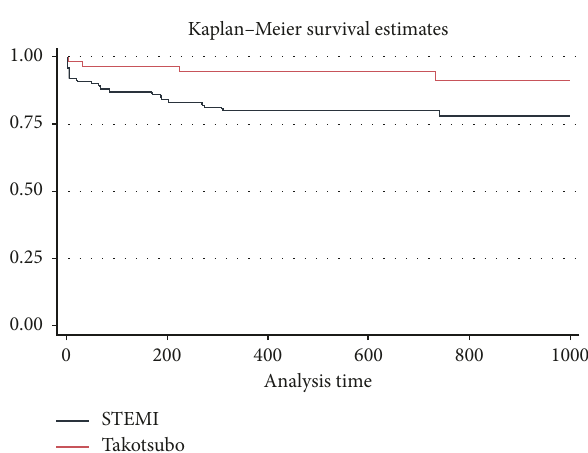
Figure 2: Kaplan–Meier survival estimates 1000days TTS and STEMI group all-cause mortality.